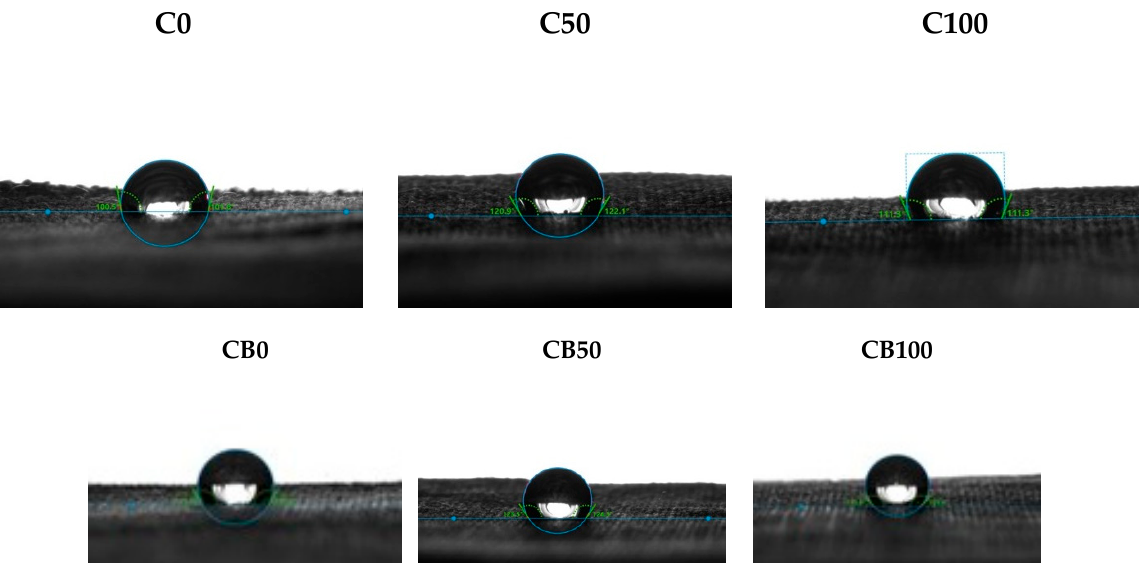
Figure 3. DSA images for samples cationized and cationized with binder.